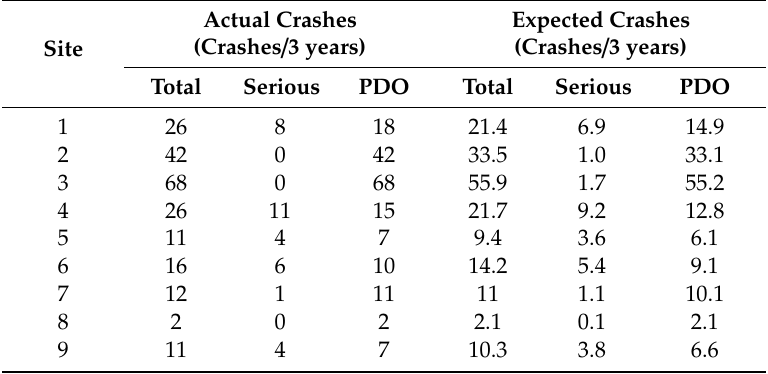
Table 4. Estimated crash e ff ects of